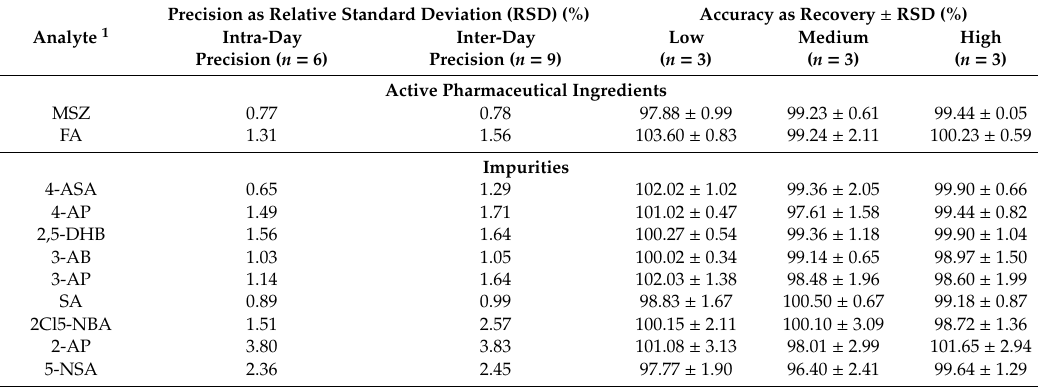
Table 2. Precision and accuracy